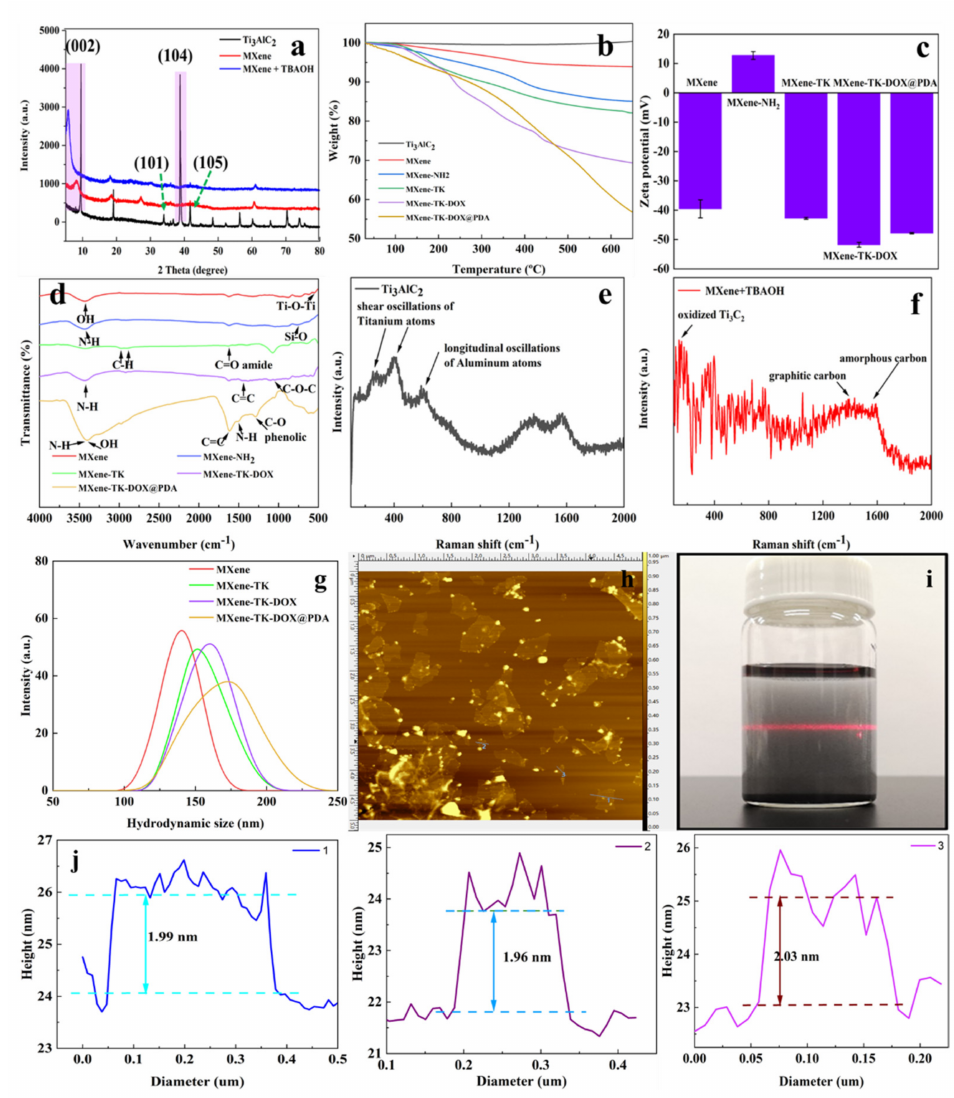
Figure 2. ( a ) XRD patterns of the Ti 3 AlC 2 , MXene, and MXene + TBAOH nanoparticles. ( b ) TGA curves of the Ti 3 AlC 2 , MXene, MXene − NH 2 , MXene − TK, MXene − TK − DOX,